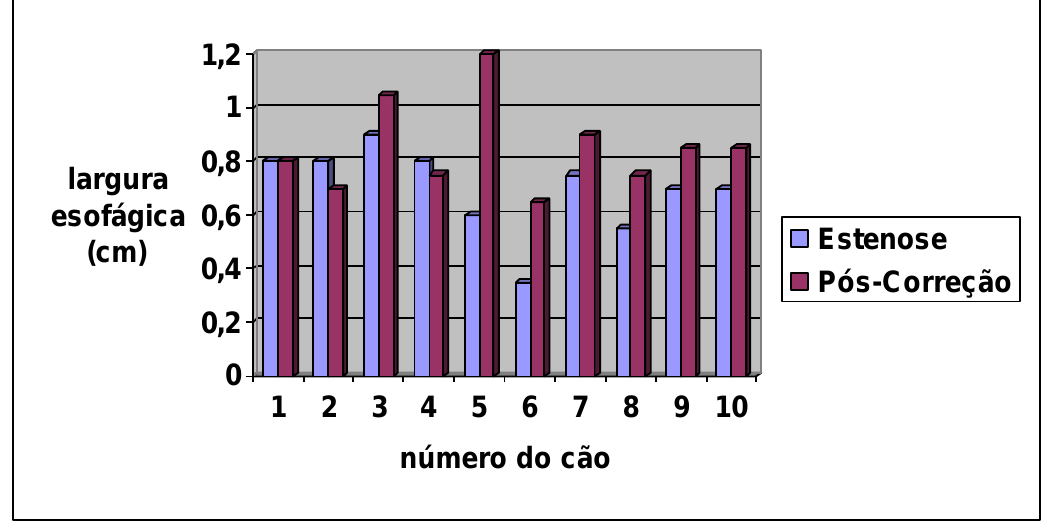
FIGURA 5 - Demonstração gráfica da largura esofágica aos tempos estenose e pós- correção.